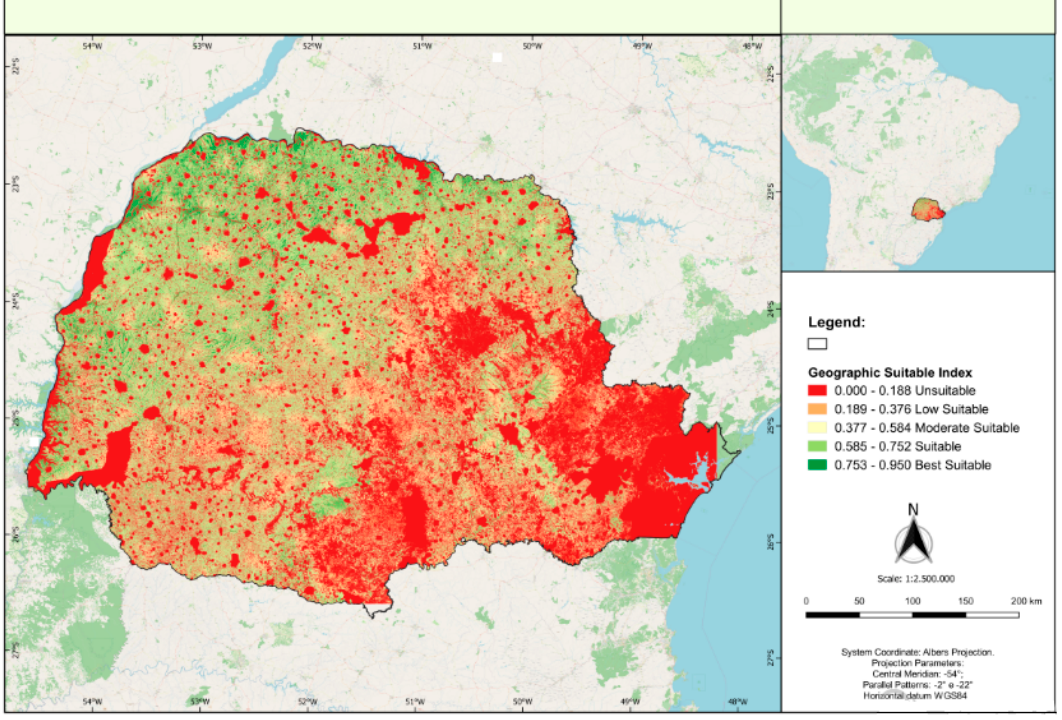
Figure 5. Geographic suitability index map.